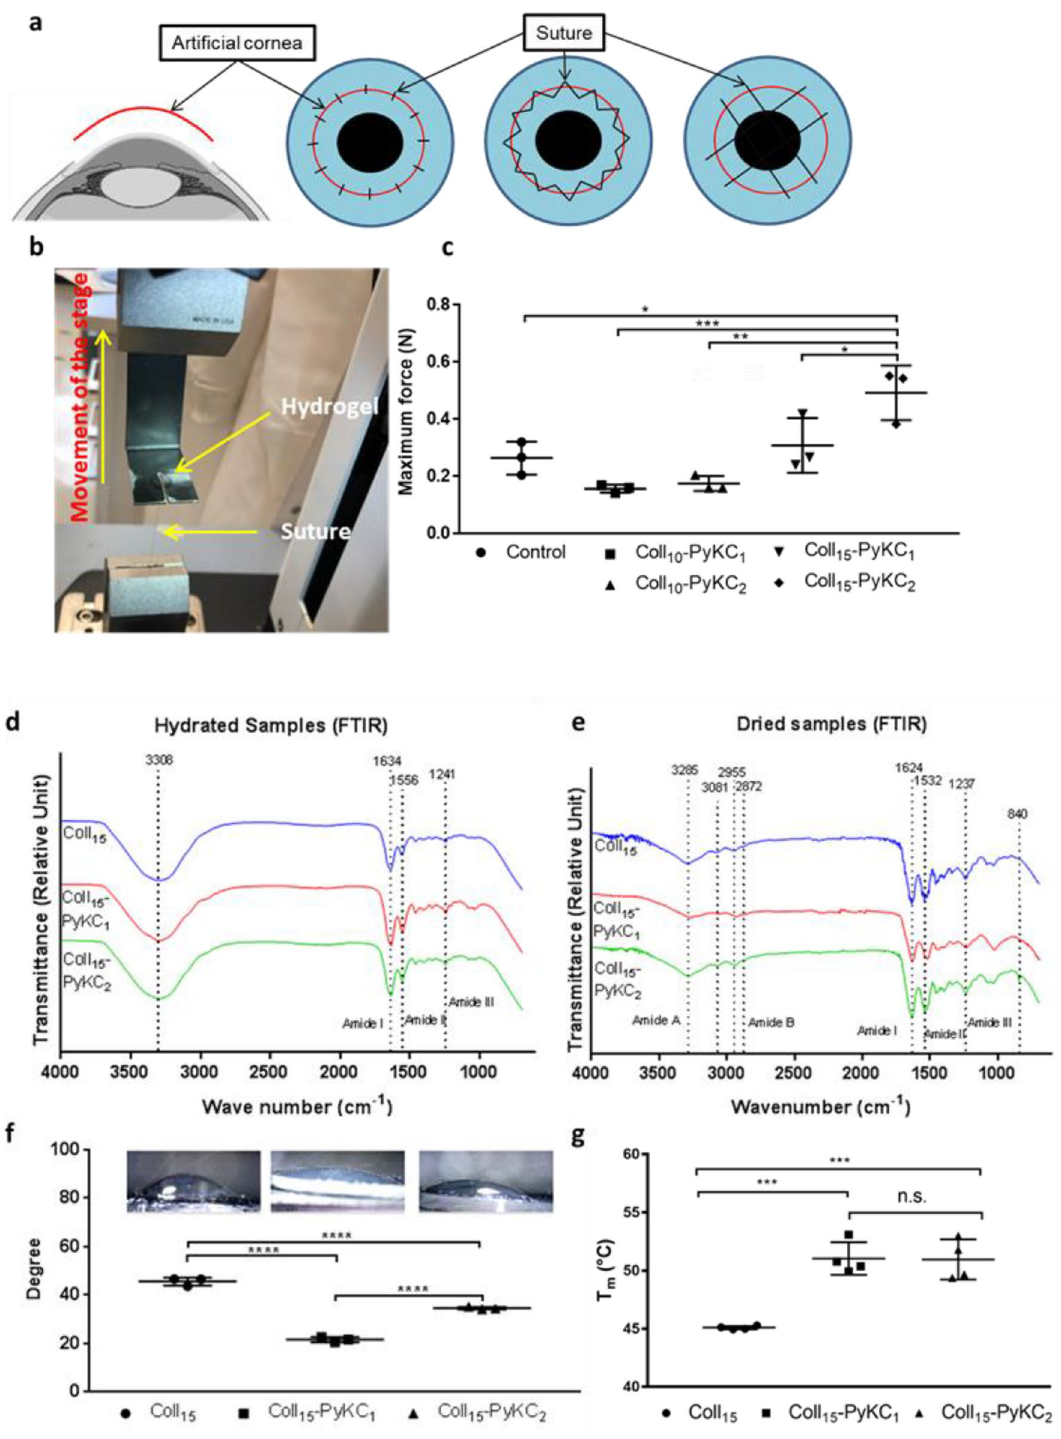
Figure 3. ( a ) Illustration of the importance of the suturability of the corneal implants. After removing the diseased cornea, the artificial cornea can be placed into the host eye with different suturing techniques. Suturing can be done through interrupted, continuous, or overlaying sutures to stabilize and retain the implant. Images were created with BioRender.com on a standard academic license. ( b ) Machine setup for the suture pull-out study. ( c ) Measurement of maximum force the hydrogels (N = 3) withstand during suture pull out study before the suture cut off the materials and comparison was made against control hydrogel (Coll 10 ). Characterization of Coll 15 -PyKC 1 and Coll 15 -PyKC 2 hydrogels compared with control Coll 15 hydrogel. FTIR spectra of hydrated ( d ) and dried hydrogel sample ( e ) of PyKC and collagen hydrogel compared with control hydrogel. ( f ) Contact angles measurement on different hydrogels with corresponding micrographs of water contact angles (N = 3). ( g ) The denaturing temperature measurement (Tm) of different hydrogels (N = 4). A value of p < 0.05 was considered statistically significant. n.s., *, **, *** and **** represent p > 0.05, p < 0.05, p < 0.01, p < 0.001 and p < 0.0001,